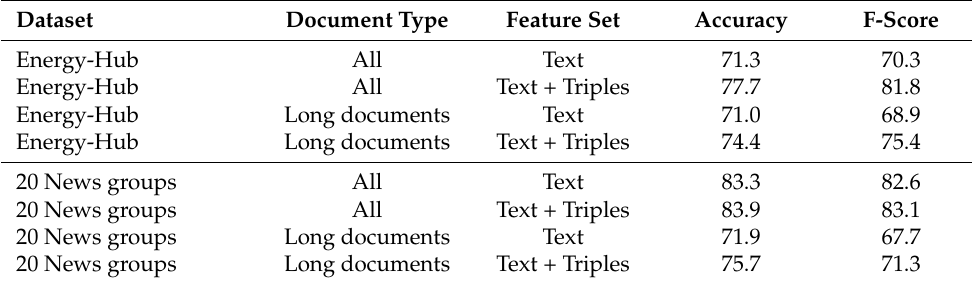
Table 5. BERT model results on long documents from Energy-Hub and 20 News groups datasets. Note: Long documents are filtered from the larger corpus using word length (documents with less than 600 words are